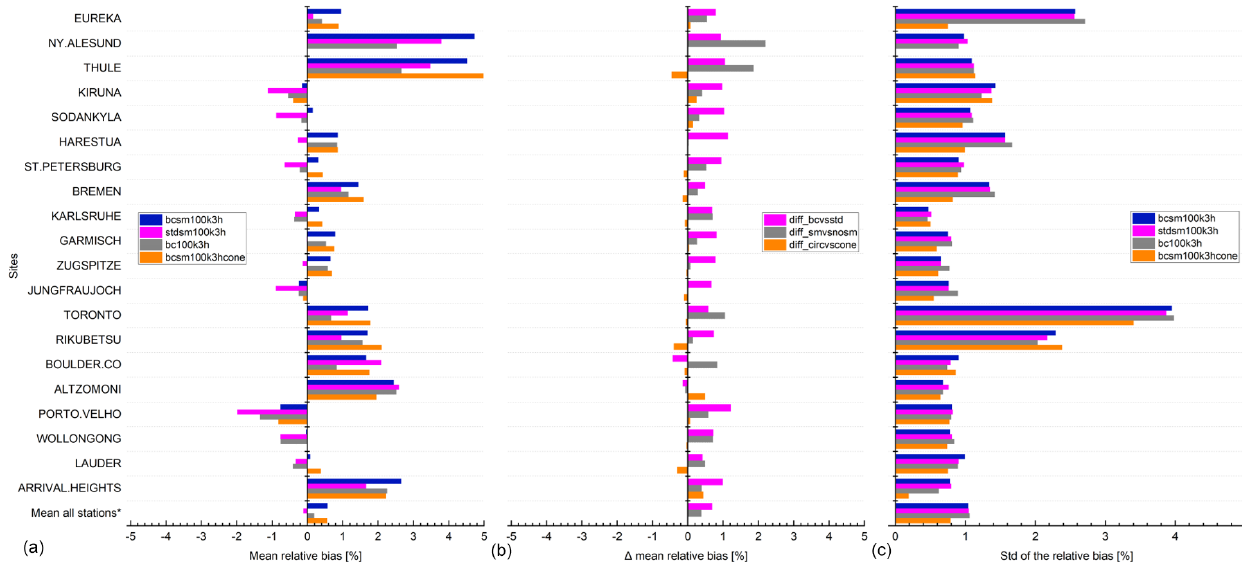
Figure 9. S5P XCH 4 validation results against NDACC XCH 4 data at 20 stations within the period between November 2017 and September 2020. (a) Bar chart of mean relative bias ((SAT – GB)/GB) in percent; (c) standard deviation of the relative bias in percent; (b) difference of the mean relative bias for validation cases (stdsm100k3h, bc100k3h, bcsm100k3hcone) in percent against the reference case (bcsm100k3h) in percent. Spatial co-location with radius of 100km or cone with 1 ◦ opening angle along the FTIR line of sight and time co-location of ± 3h around the satellite overpass were used. The stations are sorted with decreasing latitude. The mean of all stations is calculated by excluding outliers which are stations with a low number of co-locations (Ny-Ålesund, Rikubetsu), high scatter in the ground-based data (Toronto), high unexpected bias (Thule, Arrival